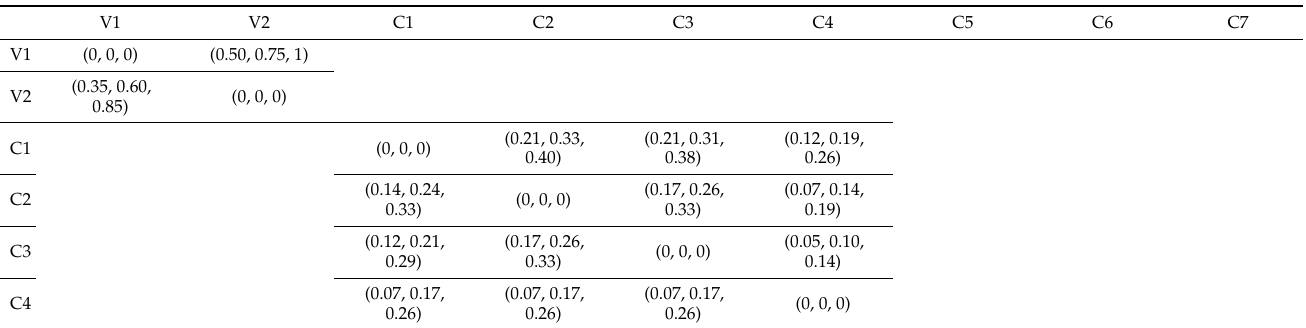
Table 3. Normalized direct relation